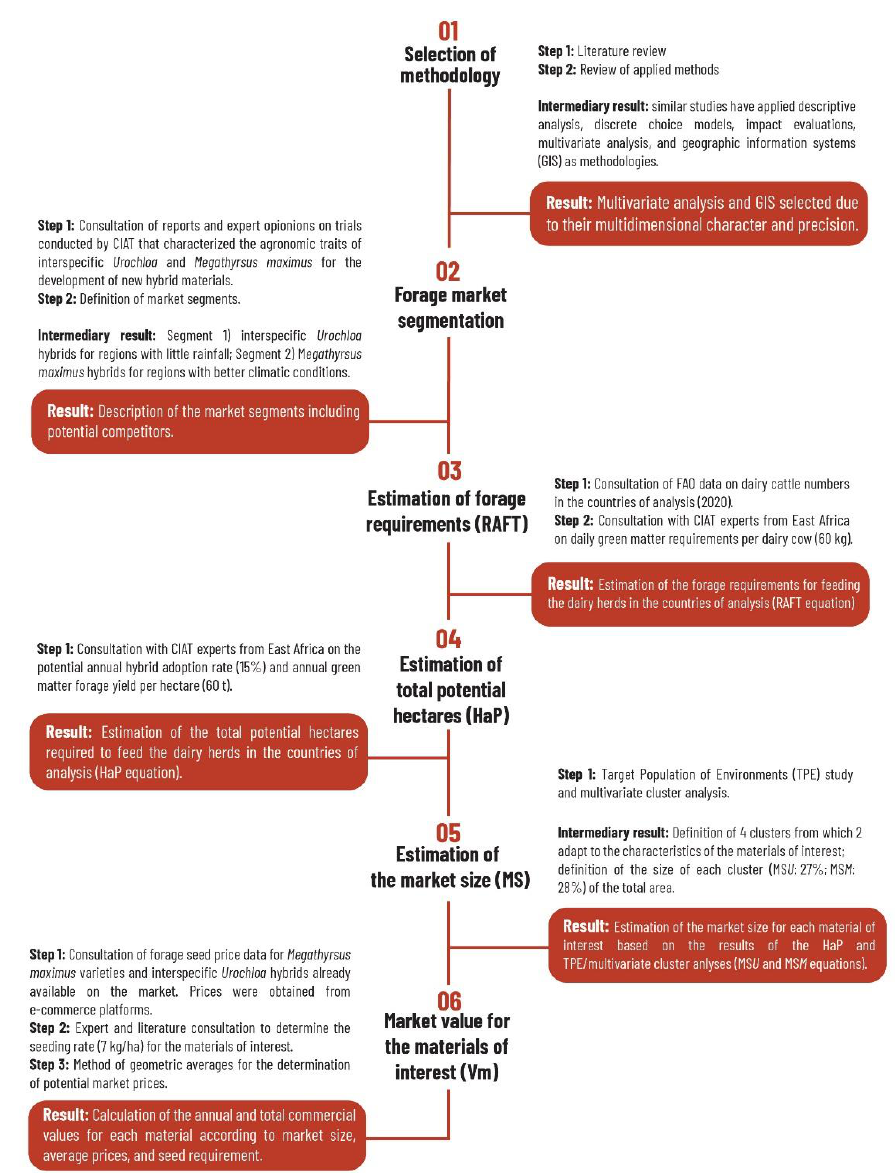
Figure 1. Methodological flowchart for the estimation of potential markets of hybrid forages in Af- rica.